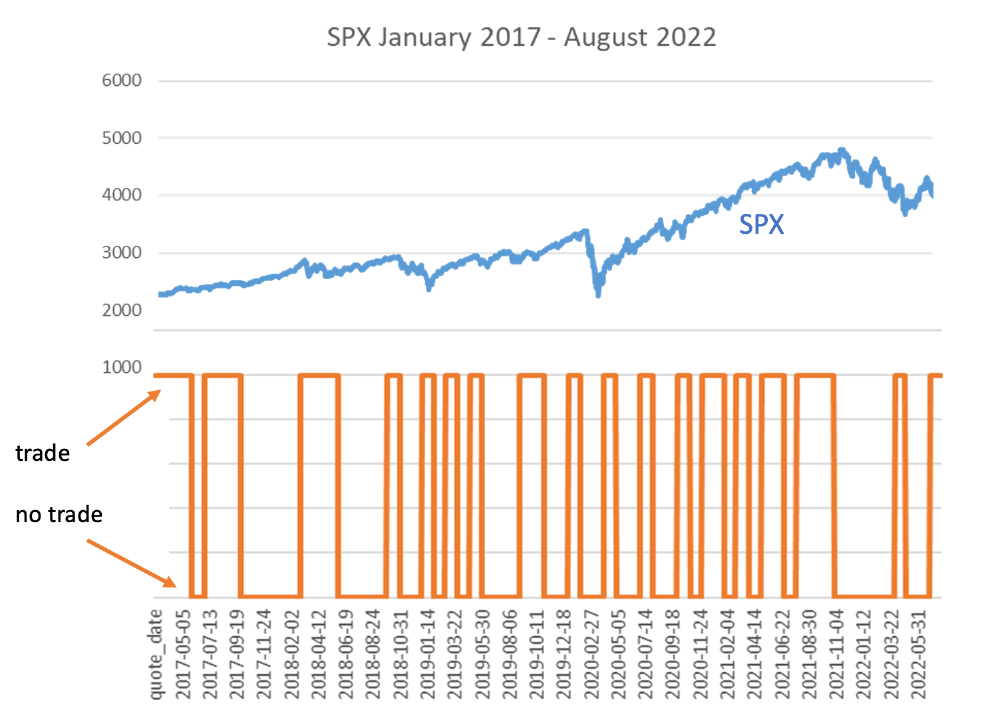
Figure 10. Trading decisions (orange line) for the gradient-boosting approach.